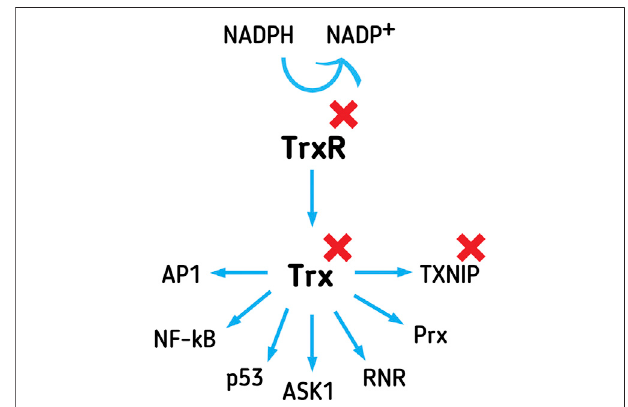
FIGURE 3 | The Trx system affects gene expression, apoptosis, proliferation, and oxidative and xenobiotics defense, through interactions with versatile executing proteins. Trx system comprises Trx, TrxR, and NADPH. TrxRreducesTrx,usingNADPHasanelectron donor.TXNIPinhibitsTrx function in the cell. Trx affects the DNA binding af fi nity of transcription factors, such as AP1, p53, and NF- κ B. Trx inhibits apoptosis-promoting protein ASK- 1 and promotes proliferation through RNR activation. Trx reduces Prx, enabling it to provide antioxidant detoxi fi cation of peroxides inside the cell. Inhibitors of the Trx system are attractive targets for the development of novel anticancer